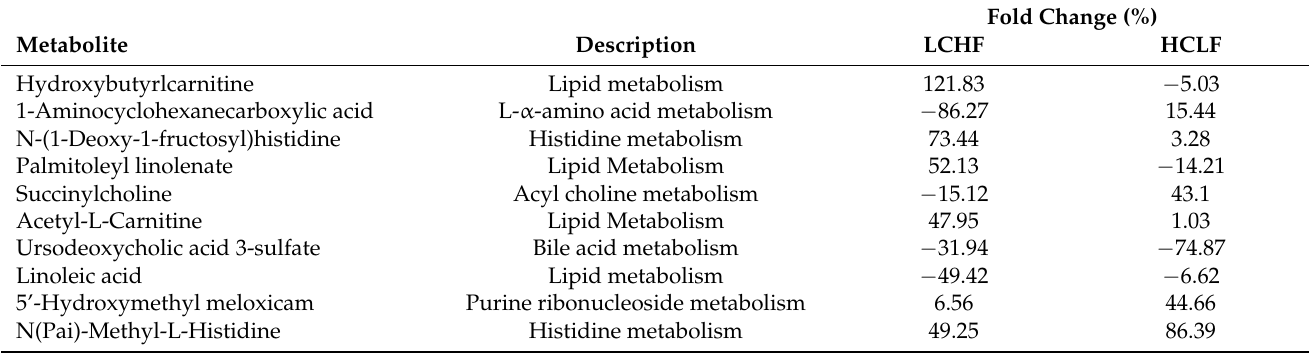
Table 3. The top 10 differential responses of metabolites following a LCHF and HCLF diet after 8